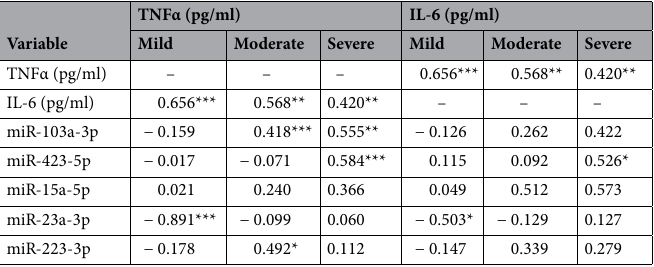
Table 6. Analysis of the correlation of miRNAs expression levels with TNFα and IL-6. The statistical significance shown are *p < 0.05; **p < 0.01; ***p < 0.001. Data were analyzed using Stata version 15.